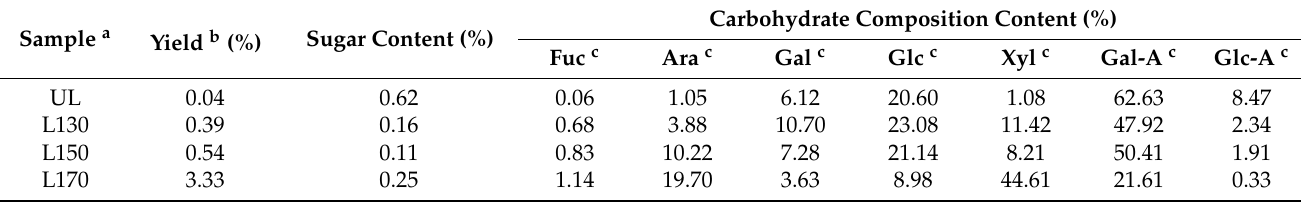
Table 1. Yields and carbohydrate contents of lignin